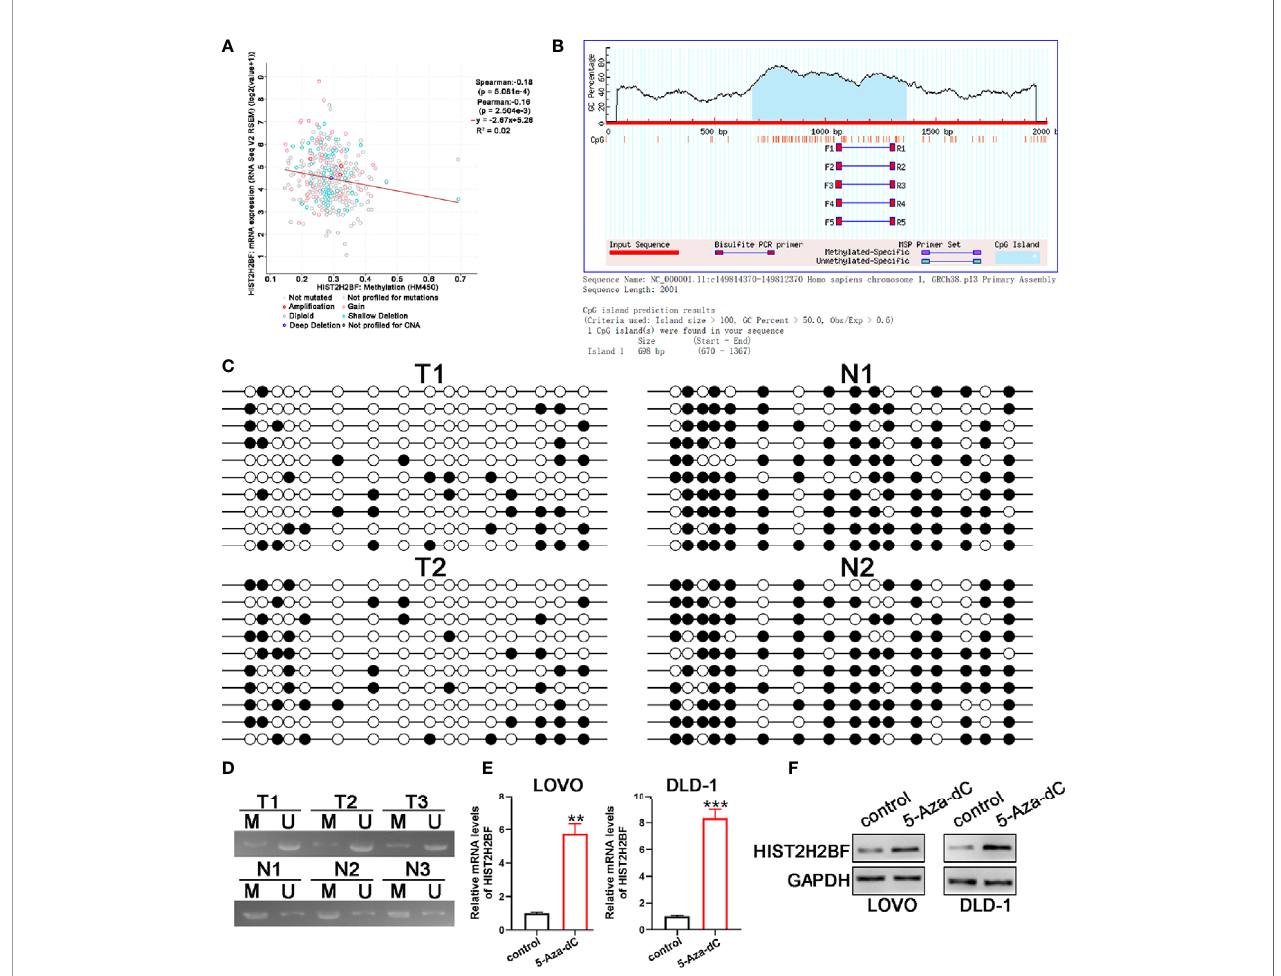
FIGURE 2 | CpG hypomethylation contributes to the upregulation of HIST2H2BF in CRC. (A) cBioPortal data were employed to display the relevance between HIST2H2BF DNA methylation status and its mRNA expression in CRC. (B) MethPrimer program was employed to predict the CpG islands of the HIST2H2BF promoter and synthesis primers. (C) Bisul fi te sequencing PCR was employed to demonstrate the methylation status of HIST2H2BF CpG islands using two paired CRC tissues and adjacent normal tissues. Open circles: unmethylated CpG sites, fi lled circles: methylated CpG sites. (D) Methylation-speci fi c PCR was employed to determine the HIST2H2BF methylation status in three paired CRC tissues (T) and adjacent normal tissues (N). M: methylated, U: unmethylated. (E, F) LOVO and DLD-1 cells were treated with 5-Aza-dC. HIST2H2BF mRNA and protein expression were then detected by RT-qPCR and Western blotting, respectively. **P < 0.01, ***P <